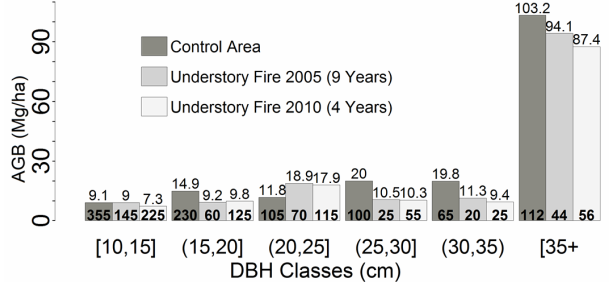
Figure 3. Aboveground biomass (AGB) in Mg · ha − 1 for Control Area (CA) (dark gray), Burned Areas (BA)-2005 (gray) and BA-2010 (light gray). Above the bars are the accumulated AGB and inside the bars are total trees in each diameter at breast height (DBH)